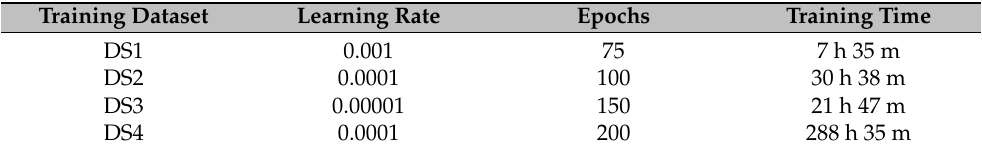
Table 5. Hyper parameters of the best performing model at each training session (Mask